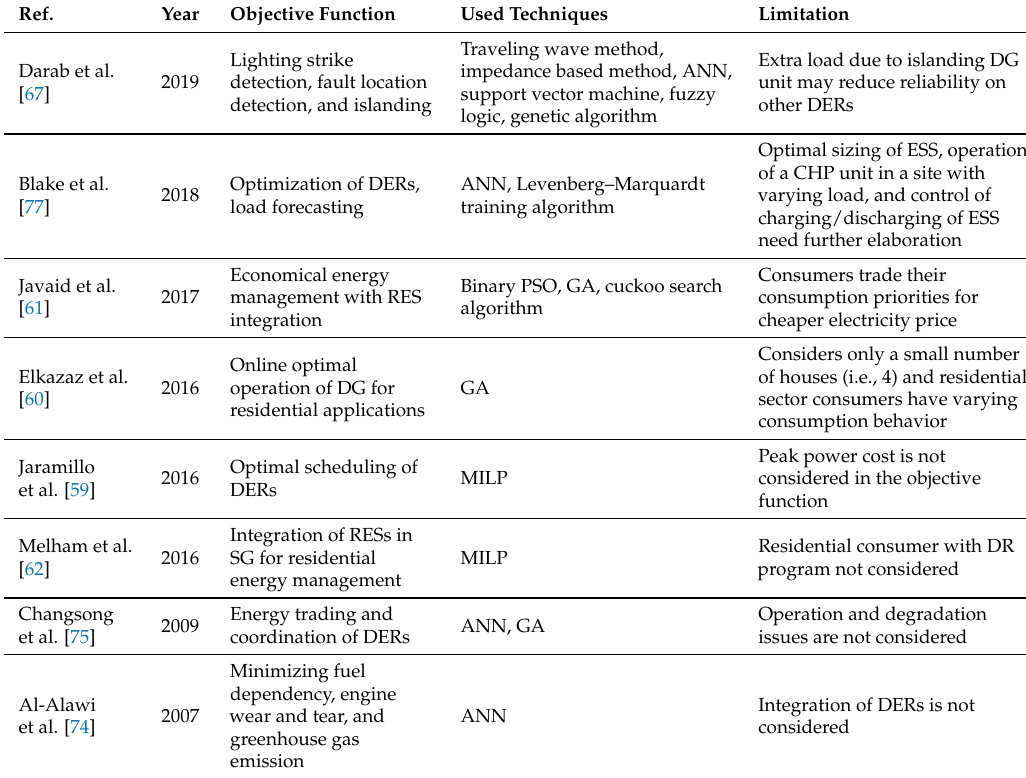
Table 2. AI techniques for the integration of